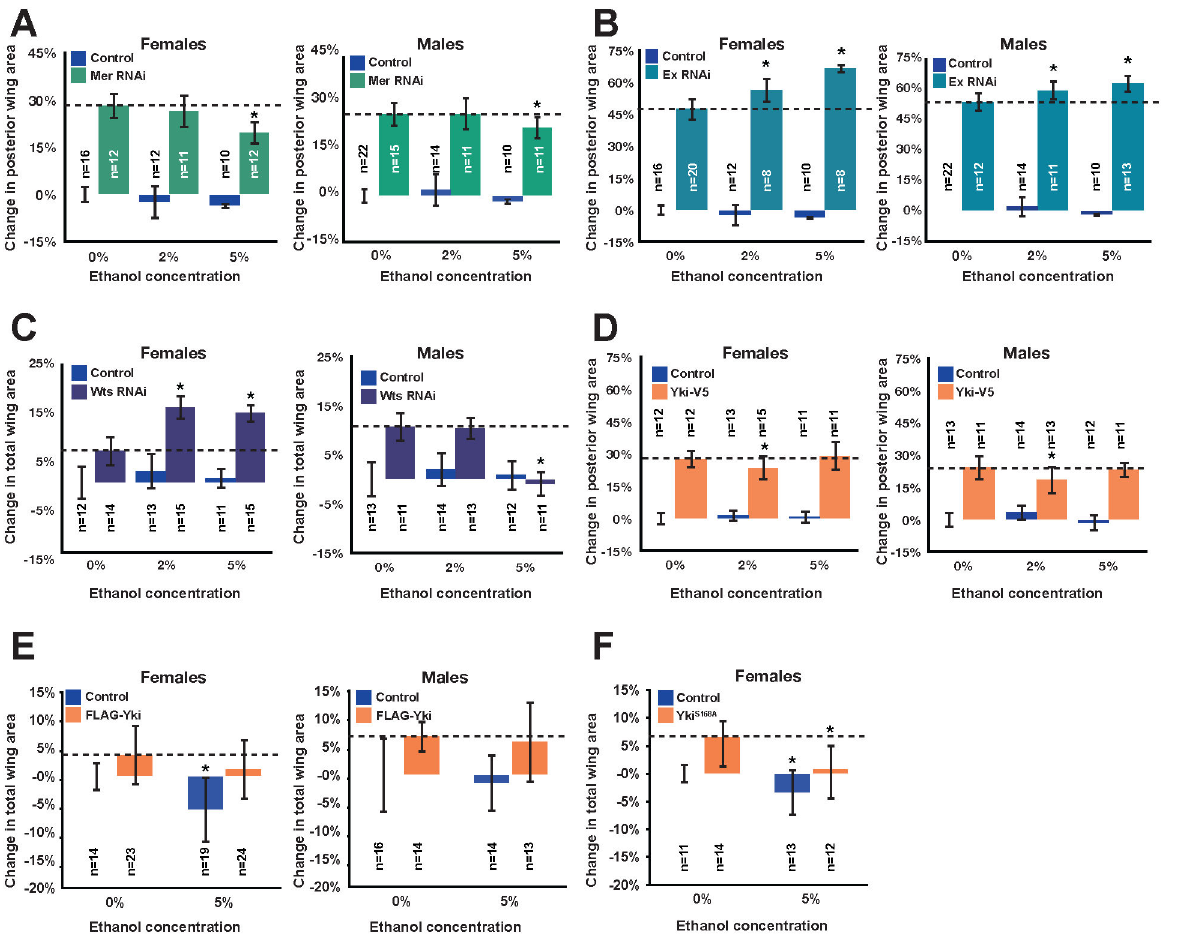
Figure 2. Ethanol enhances wing overgrowth associated with loss of Expanded, and Warts but not over-expression of Yorkie. (A-F) Percent change in posterior wing area (A-B, D) or total wing area (C, E-F) normalized to controls ( en>dcr2 for A-B, c765gal4/+ for C, E-F, engal4/+ for D) at 0% ethanol was graphed for each gene and for controls for food containing the indicated doses of ethanol (0%, 2%, and/or 5%) ethanol for (A) Mer RNAi in the posterior wing (* indicates p=1.08025E-05 for females at 5%, p=0.02382138 for males at 5%), (B) ex RNAi in the posterior wing (* indicates p=3.74229E-10 for females at 2%, p=0.005567613 for males at 2%, p=0.000441271 for females at 5%, p=3.00164E-05 for males at 5%), (C) Wts RNAi in the wing (* indicates p=1.64464E-7 for females at 2%, p=8.18059E-7 for females at 5%, p= 8.0633E-11 for males at 5%), (D) ykiV5 over-expression in the posterior wing (* indicates p=0.004919 for females at 2%, p=0.041432 for males at 2%), (E) FLAGyki over-expression in the wing (*indicates p=0.000884273 for control females at 5%), and (F) ykiS168A over-expression in the wing (* indicates p= 0.00038782 for ykiS168A females at 5%; also, in this experiments, * indicates p=0.012339878 for female control wings at 5% compared to control wings at 0%). P values are given for comparisons of the same genotypes reared on the indicated doses of ethanol to those reared on control food lacking ethanol. Experiments in A-E were conducted at 21°C, experiments in C-D were conducted at 25°C, experiments in E were conducted at 18°C, and experiments in F were performed at 16°C. doi: 10.1371/journal.pone.0078880.g002 red wild-type tissue show roughly equal white and red tissue. Ethanol doses of 1-10% decreased the percentage of eyes in Mosaic eyes containing tissue homozygous for hpo MGH1 , a the mild “+” category and increased the percentage of eyes that strong hypomorphic allele, show over-representation of mutant were scored as moderate and severe (“++” or “+++”) (Figure tissue (white) compared to wild-type tissue (red) [35] in a range 1K). At 5% ethanol, approximately 50% of eyes were severe of over-representation from mild (“+” = more white than red, (compared to less than 15% reared on 0% ethanol); at 7.5% about 65% of the eyes, Figure 1H) to moderate (“++” = strongly ethanol, this increased to over 60% of eyes. more white than red, about 20% of eyes, Figure 1I) to severe (“+++” = almost all white, about 10-15% of the eyes, Figure 1J).